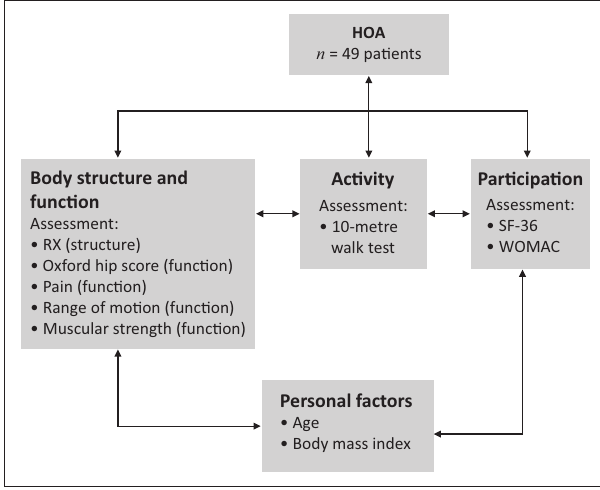
FIGURE 1: Evaluation of patients using the International Classification of Functioning, Disability and Health